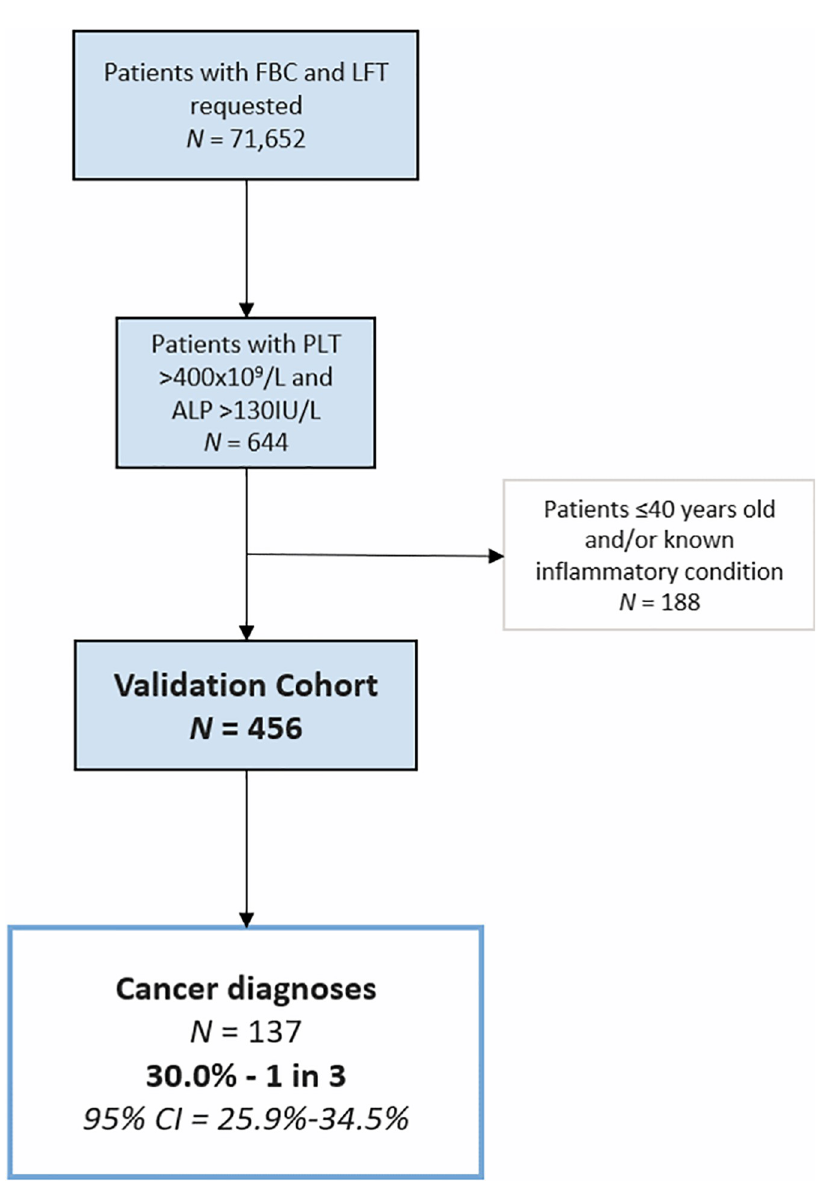
Fig 3. Flowchart depiction of formation of validation cohort with exclusion criteria applied. Number of cancers found within cohort shown with 95% confidence intervals (CI).